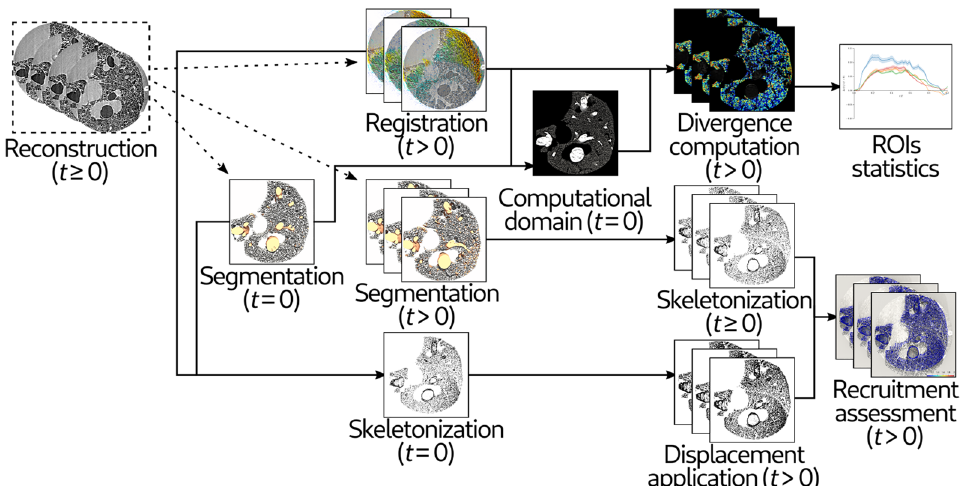
Figure 6. Image processing scheme. Sequential images were reconstructed at successive phases of breathing and heart contraction. Pairwise image registrations were performed between each time step and the immediately previous one. Deformation as a result of breathing or cardiac activity was computed and mapped. The presence of alveolar recruitment was investigated by comparing segmentations of the airspaces at each time step to the segmentation at time t = 0, properly realigned according to the results of image